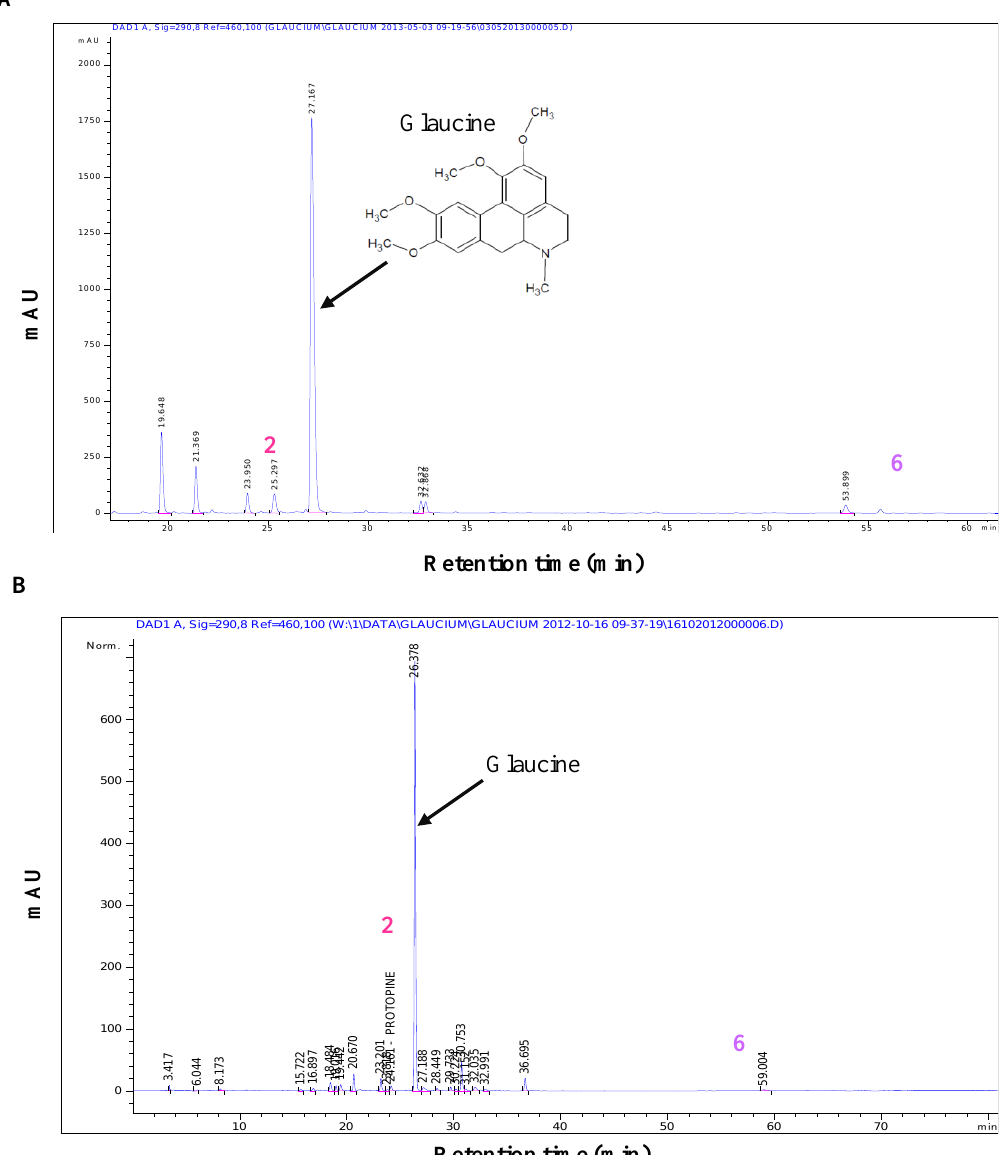
Figure 3. Representative HPLC-DAD chromatograms of alkaloidic extract ( A ) and methanolic extraction of the dry powder ( B ) of aerial part of G . flavum . Peaks ( 2 ) and ( 6 ) correspond to quantified compounds in plant (protopine and bocconoline,